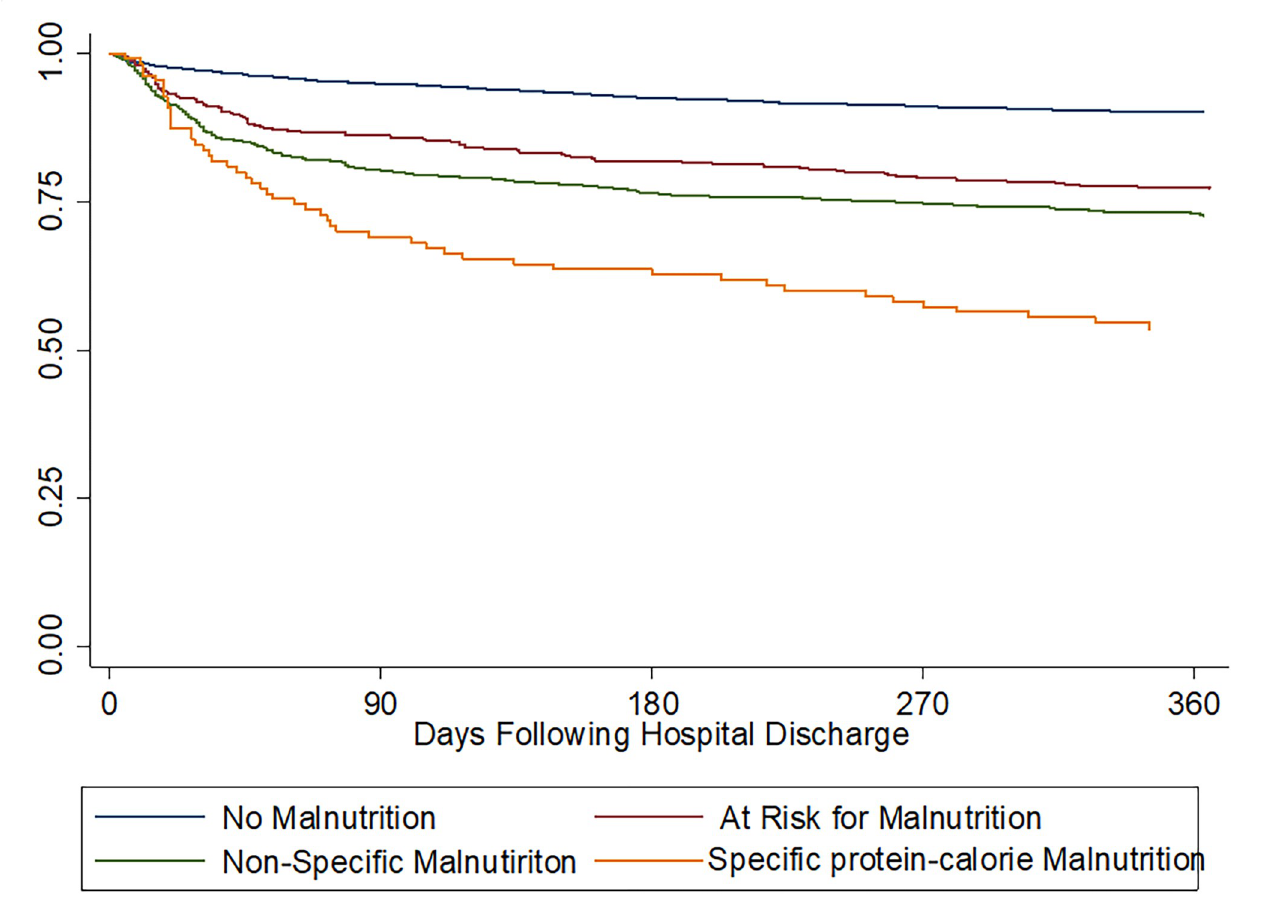
Fig 1. Time-to-event curves for mortality. Unadjusted mortality rates were calculated with Kaplan-Meier methods and compared with the log-rank test. Categorization of nutrition groups is per the primary analysis. The global comparison log rank P value is < 0.001, indicating significantly different survival patterns.